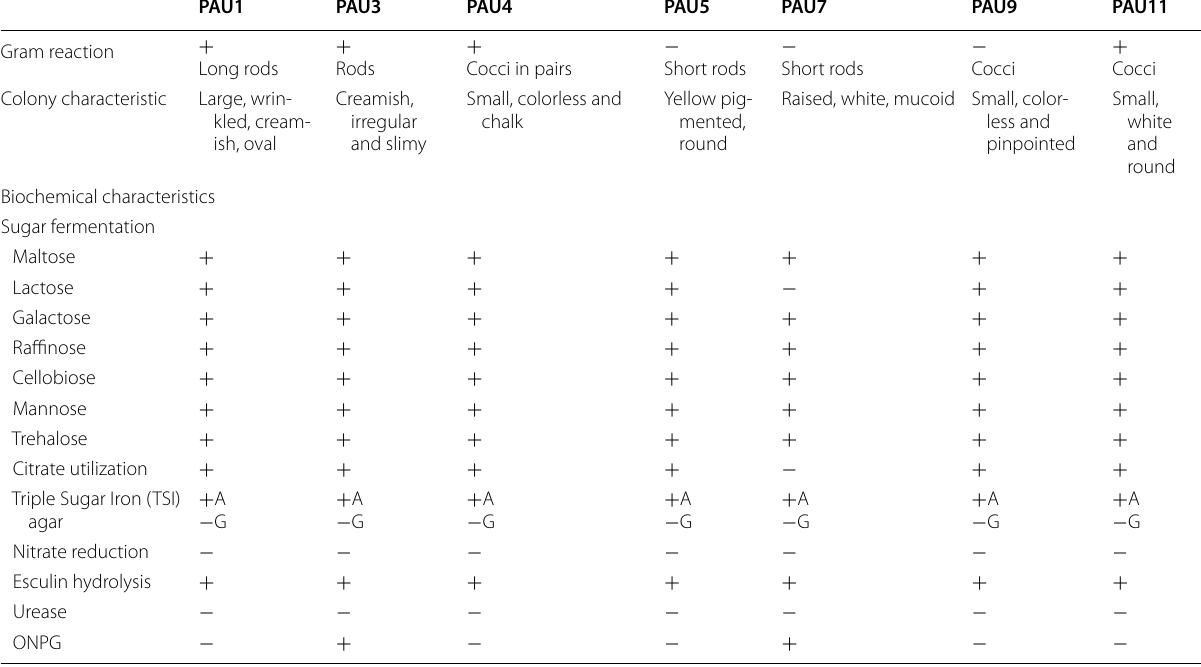
PAU (in isolate name) used as a label and signifies Punjab Agricultural University